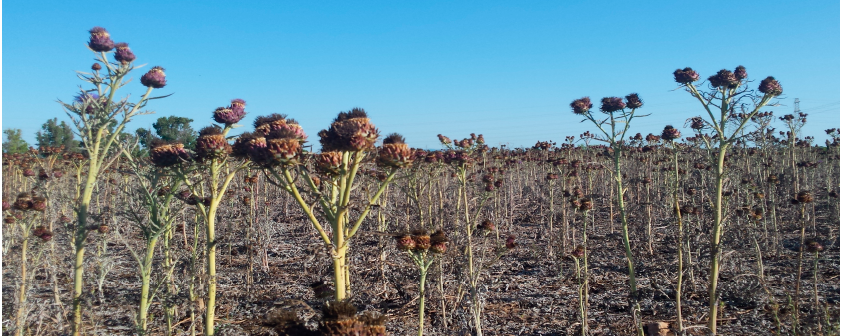
Figure 7. A recent cardoon crop in Sant’ Apollinare.